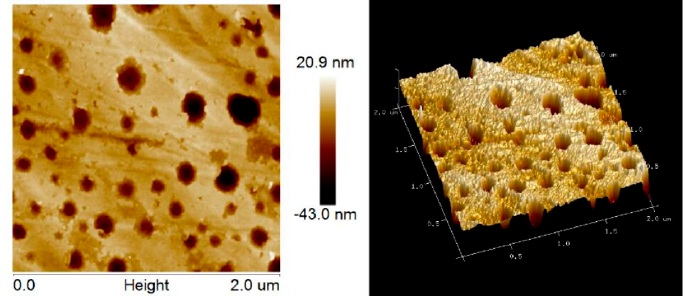
Figure 4. Atomic force microscopy (AFM) images of film, phase image and 3D images of the film F 1-1 (The scanning scale is 2 μ m × 2 μ m).